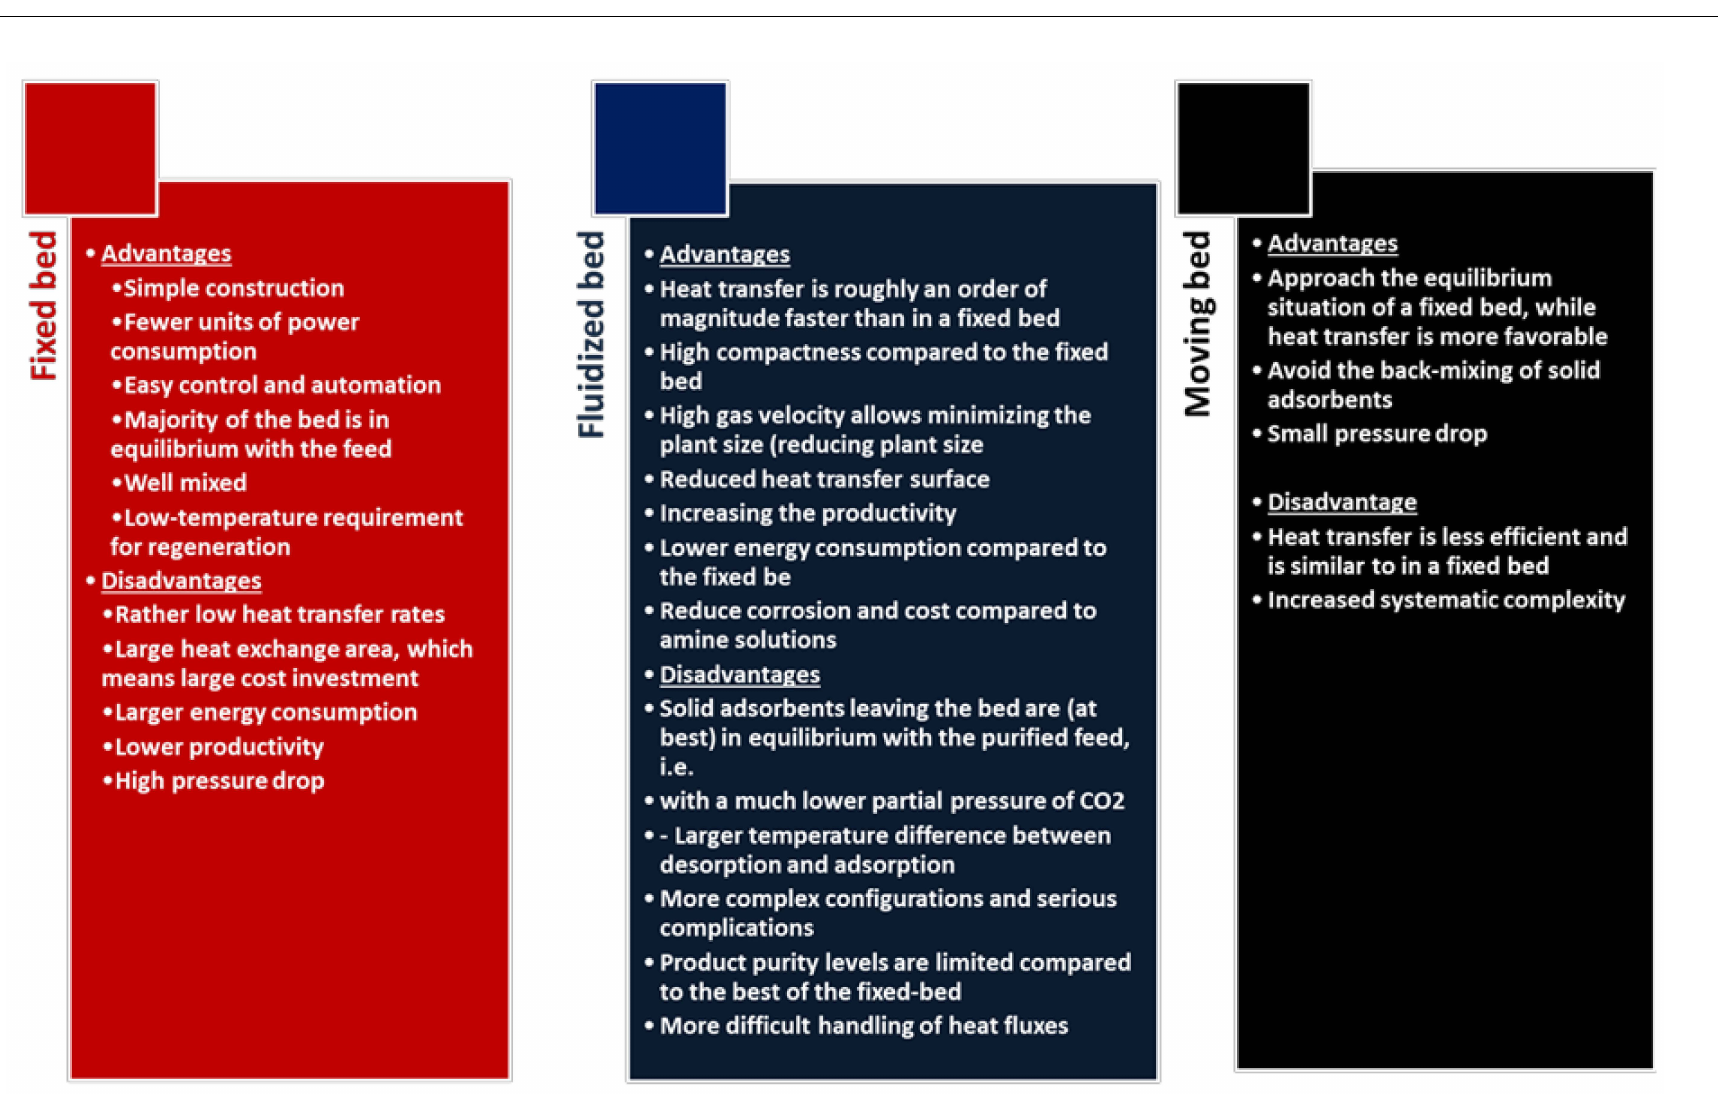
Figure 6. The merits and demerits of the fixed bed, fluidized bed and moving bed